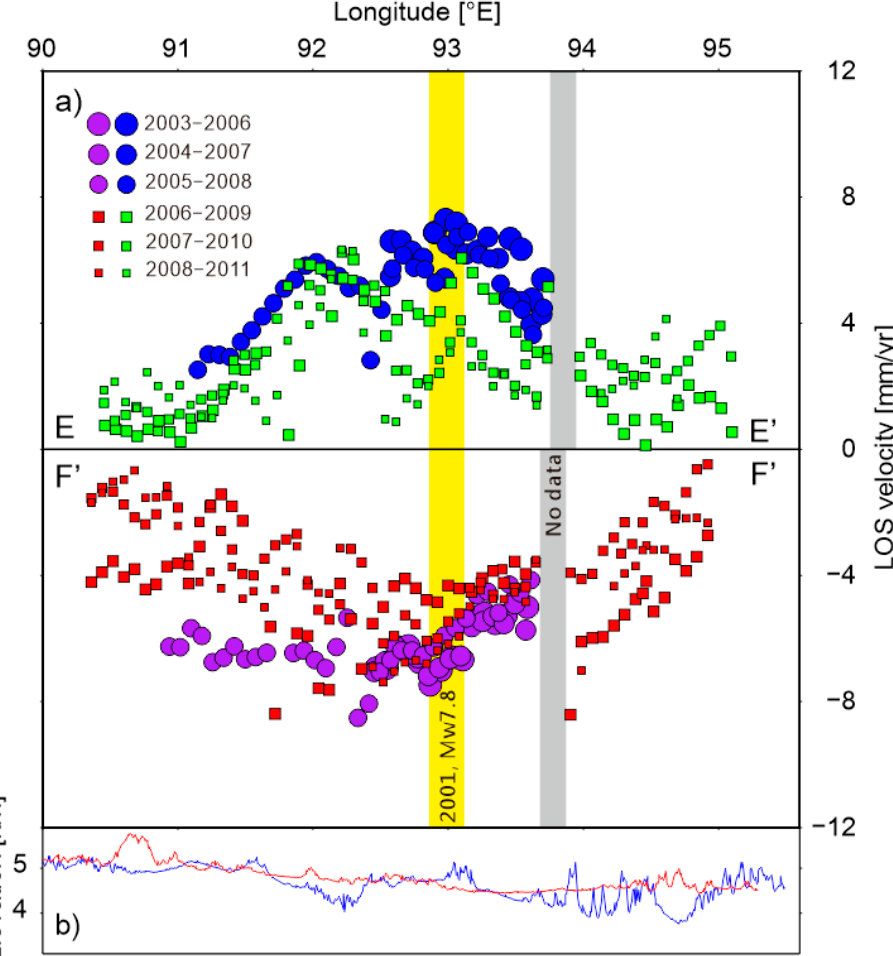
Figure 12. ( a ) Comparison of postseismic velocities profiles in parallel-fault direction in six periods to show temporal and spatial characteristics of the postseismic deformation in the southern and northern side of the fault (for profile locations EE’ and FF’ see in Figure 11). The yellow bar denotes the moment centroid (GCMT) of the 2001 Kokoxili earthquake; ( b ) Elevation variation along profiles EE’ and FF’.